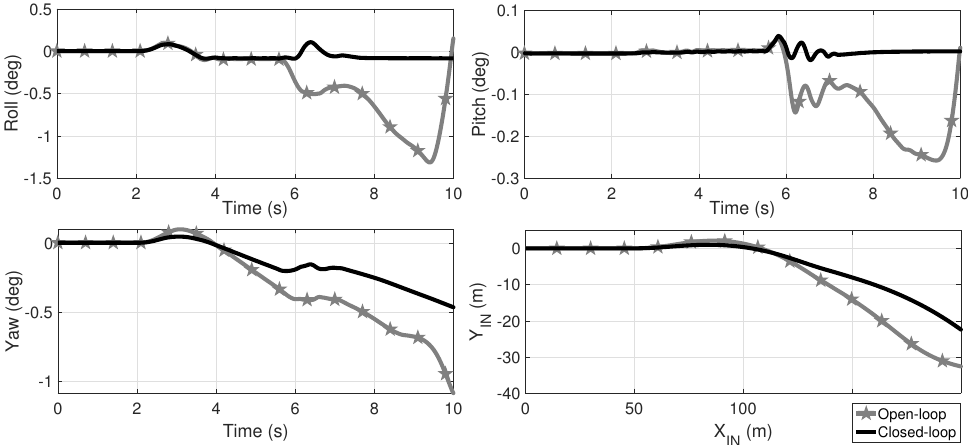
Figure 10. Comparative of the roll, pitch and yaw angles as well as the TWV displacement for open (black plots) and closed-loop (gray-star marked plots), and a friction coefficient µ = 0.65 for the maneuver of Figure 2a augmented by 300%. At the second 5.6, a speed bump is simulated by an exogenous road step (Figure 2b) in the front wheel and 0.1 seconds later in the rear right wheel. In open-loop, the vehicle suffers a rollover from second 6 as the roll angle indicates and in closed-loop the rollover is avoided; since the three wheels lose ground contact at second 5.8 oscillations are expected at TWV landing. In the Supplementary Material Section, a link is provided to video